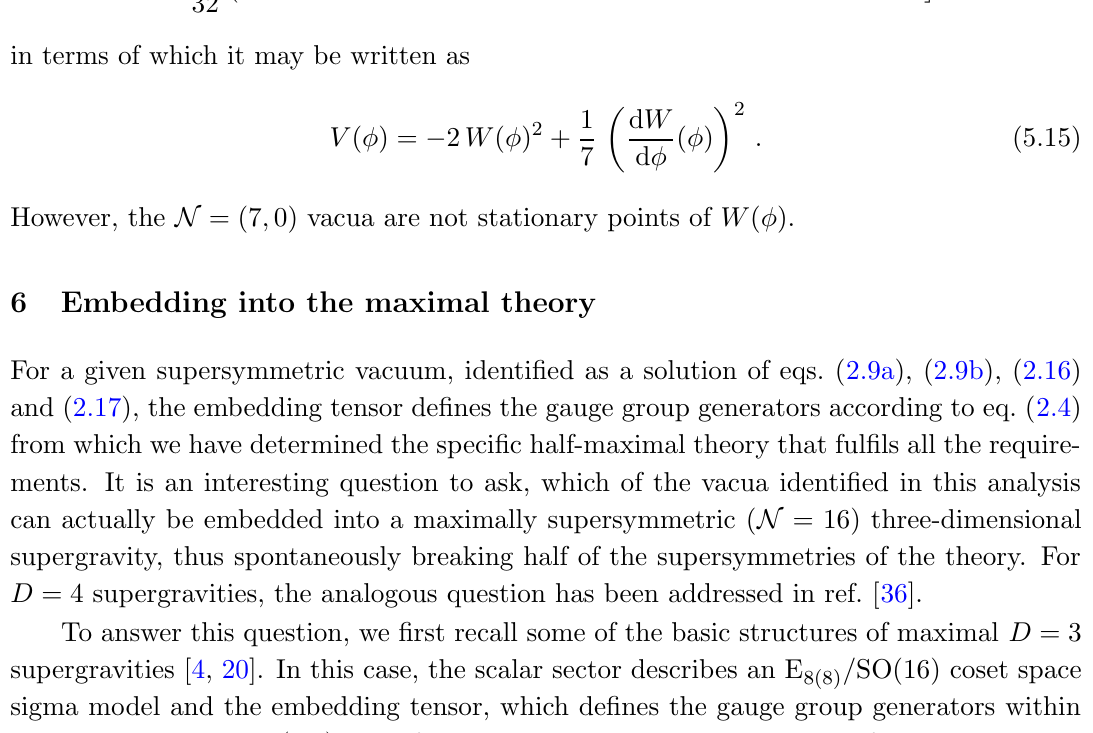
G 2 . (cid:2) = (8 ; 0) supersymmetry, while the two N = (7 ; N